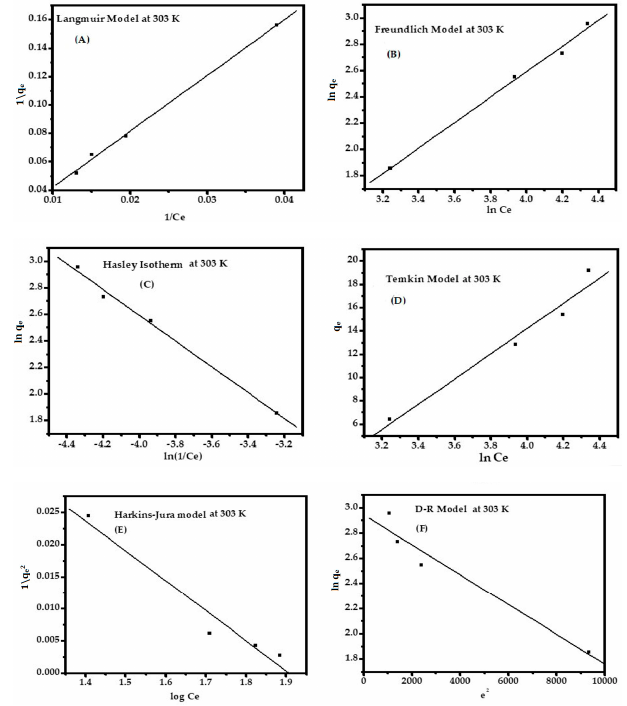
Figure 6. Different types of adsorption isotherm: Langmuir ( A ); Freundlich ( B ); Hasley ( C ); Temkin ( D ); H–J ( E ); and D–R ( F ) for MB dye in pH 12.01 at 303 K.